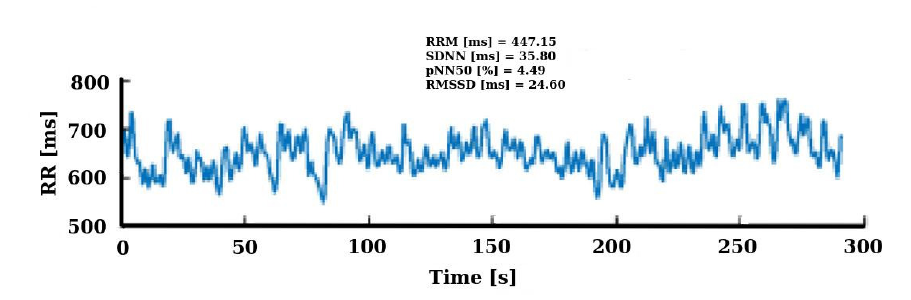
Figure 2: Cardiotachogram on healthy subjects showing time-domain indexes. The abscissa and ordered axes represent time in seconds and RR intervals in ms, respectively.